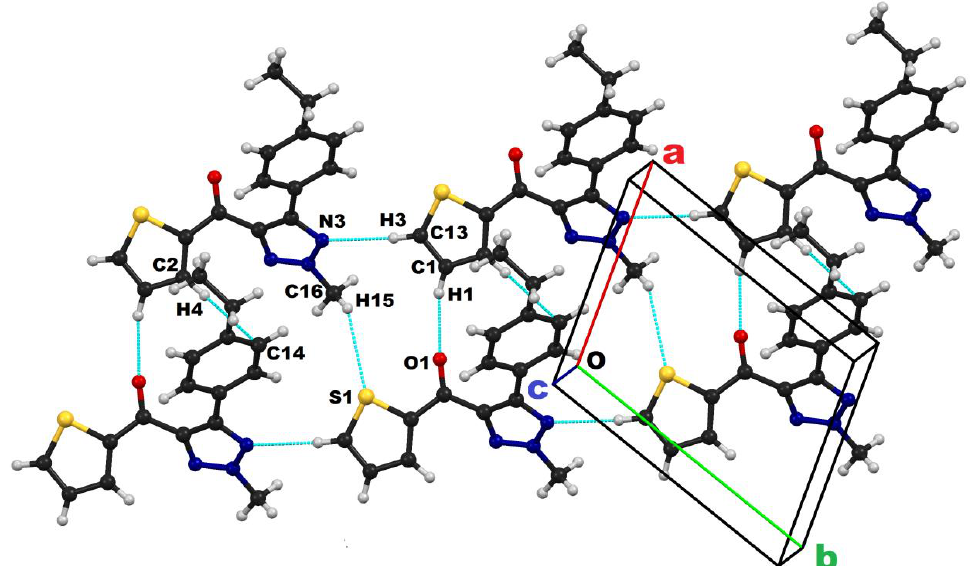
Figure 3. Packing network of molecules down the ab plane associated with C-H···N, C-H···O hydrogen bonds and C-H···S and C-H···π intermolecular contacts.